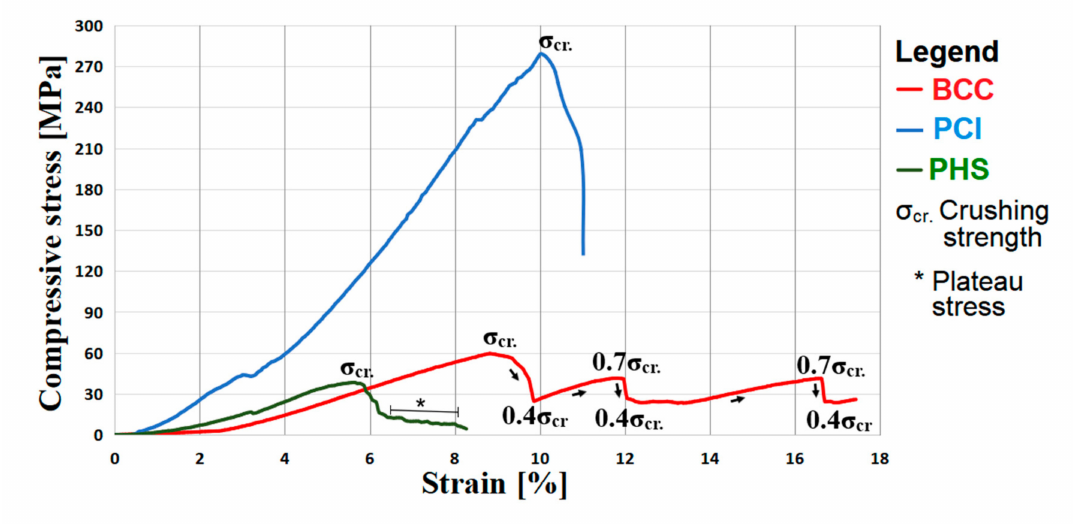
Figure 4. Stress–strain curves of lattice